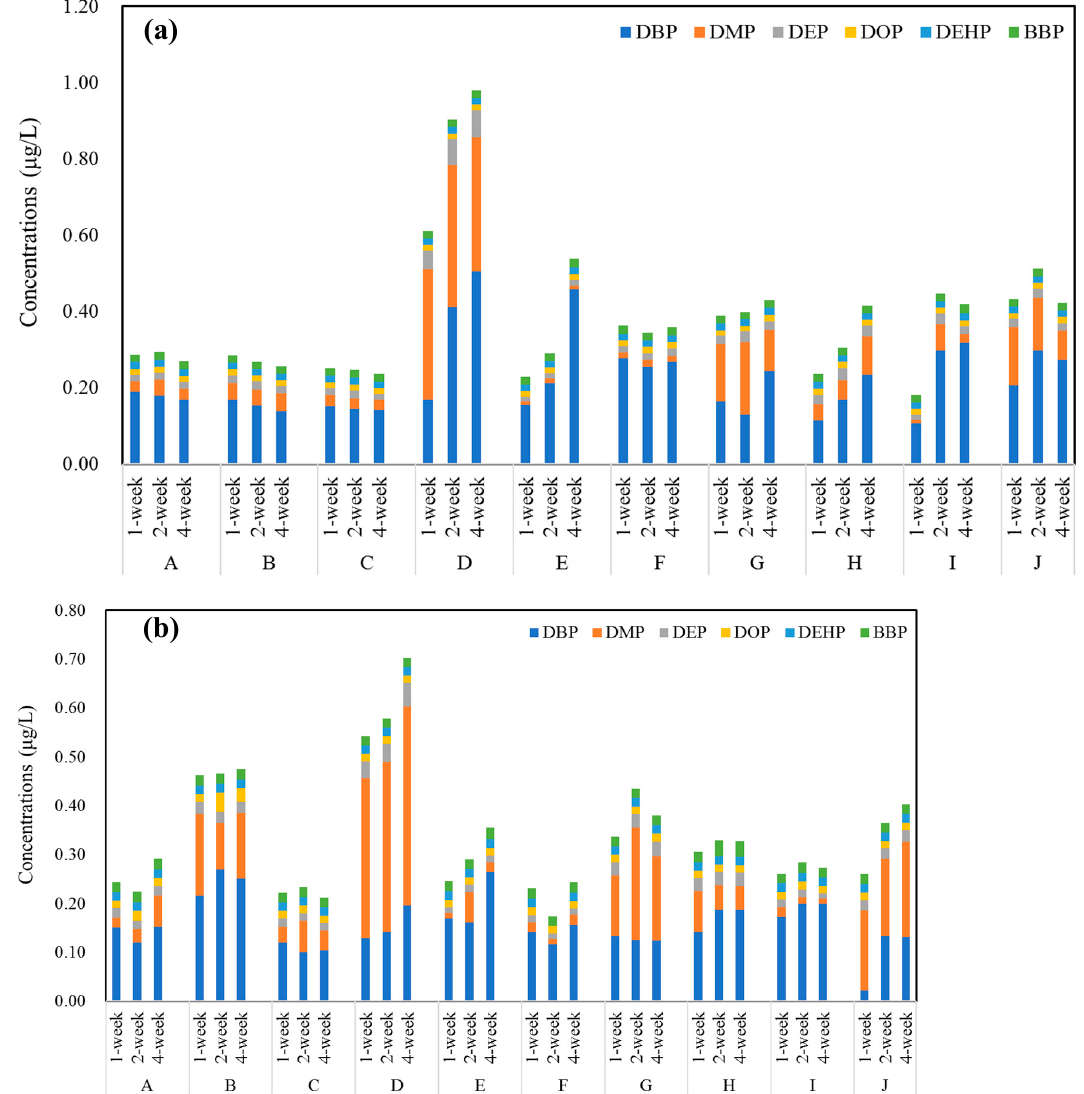
Figure 2. Total concentrations ( µ g / L) of PAEs in each brand of PET bottled water stored ( a ) outdoors and ( b ) in lab for 4 weeks, respectively ( n = 3).